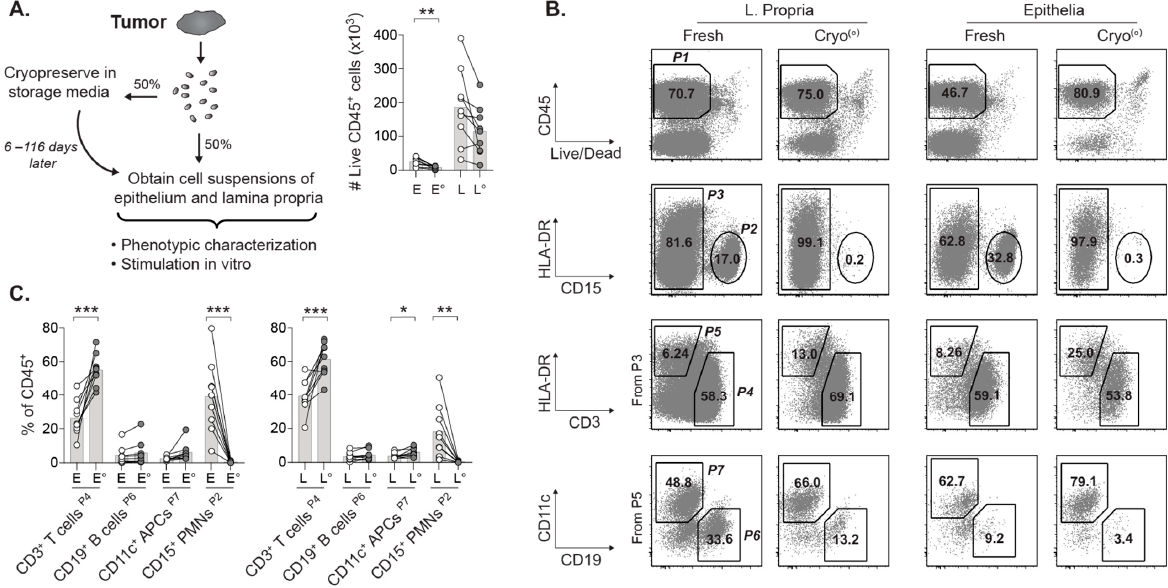
Figure 1. Recovery of CD45+ leukocytes in cryopreserved tumors of rectal cancer patients. ( A ) Experimental overview and number of viable CD45+ leukocytes. ( B ) Gating strategy for epithelial and lamina propria cell suspensions of fresh and cryopreserved portions of the same tumor. The CD45+ leukocytes ( P1 ) comprise CD15+ PMNs ( P2 ), and the remaining leukocytes ( P3 ) are divided into CD3+ HLA-DR dim/– T cells ( P4 ) and HLA-DR+ APCs ( P5 ). The CD19+ B cells ( P6 ) and CD11c+ myeloid APCs ( P7 ) are from P5 . Percentages of parent population are shown. ( C ) Frequencies of cell subsets within CD45+ leukocytes. E and L denotes epithelia and lamina propria, respectively. °indicates the cryopreserved tumor portion. Bars show the mean. (* p < 0.05, ** p < 0.01, *** p < 0.001, Welch’s t test).